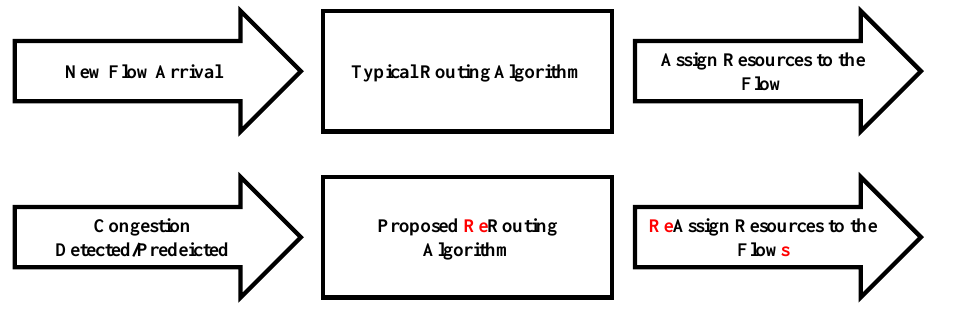
Figure 2. Outline of the proposed schemes. The proposed scheme can work with any of existing routing algorithm. In this architecture, a typical routing algorithm routes one flow in each step while the proposed rerouting algorithm reroutes several flows to reduce the packet loss and provides a better QoS (quality of service) to the users.